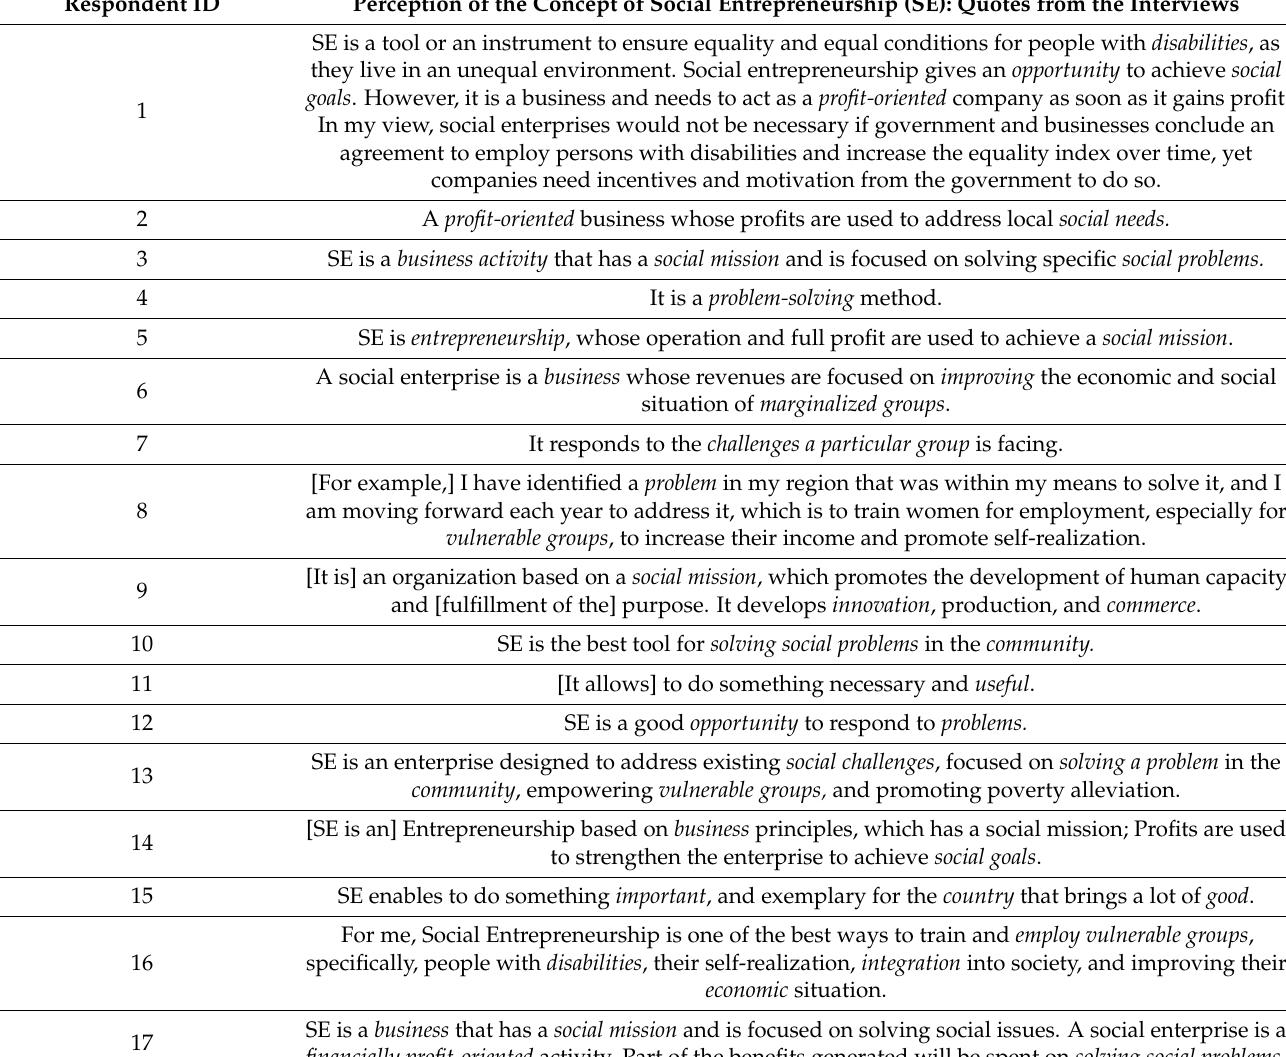
Table 4. What does social entrepreneurship